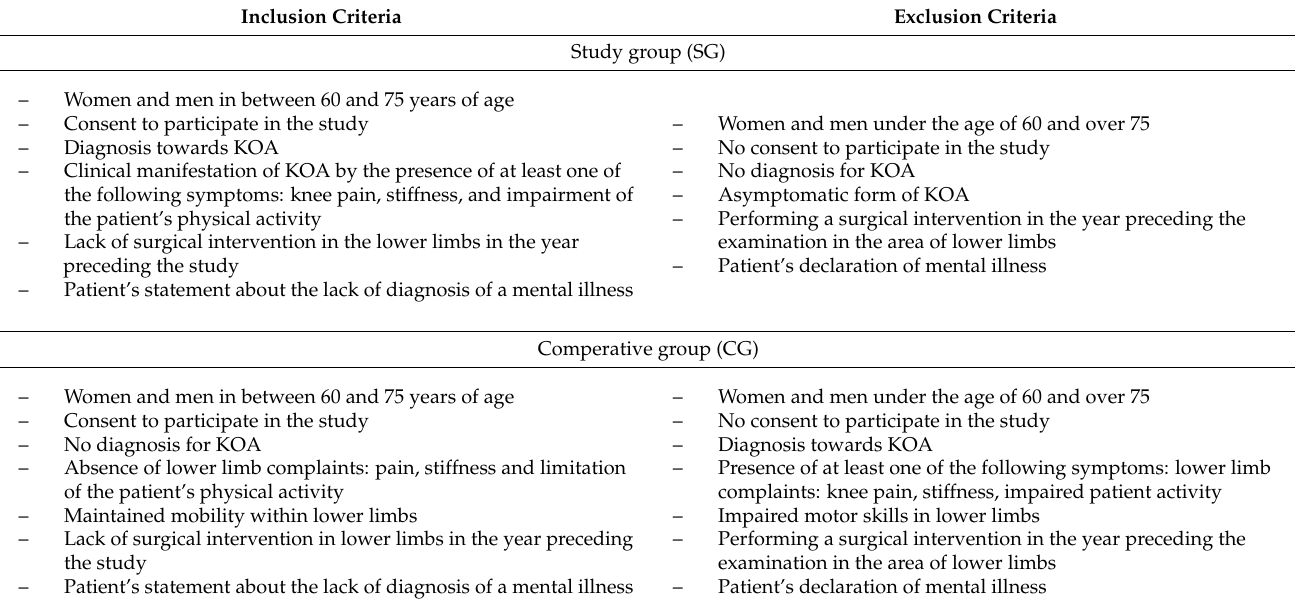
Table 1. Inclusion and exclusion criteria for SG and